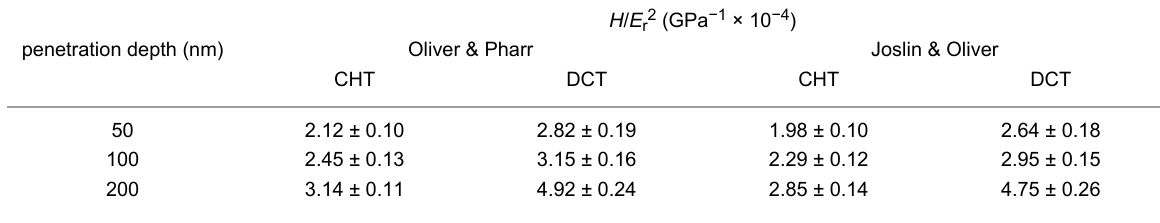
Table 3: Comparison of the H / E r2 values obtained by the Oliver & Pharr and Joslin & Oliver methods.